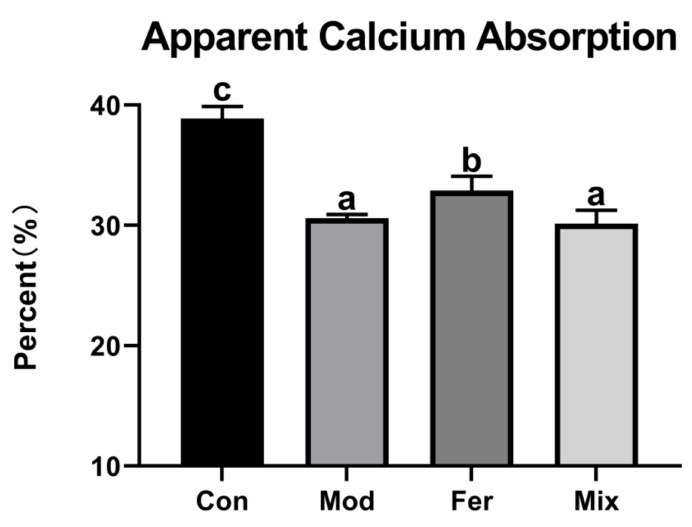
Figure 1. FS more significantly restored apparent calcium absorption in osteoporotic rats. Rats in each group were fed in metabolic cages 3 days before the end of the experiment, and the intake, gavage volumes, and feces were recorded for 3 days. Calcium content was detected by ICP-MS. Apparent calcium absorption (%) = (calcium intake − fecal calcium)/calcium intake × 100%; calcium intake (g) = calcium content in feed (g/kg) × feed consumption (kg) + gavage dose (mL) × gavage calcium content (g/mL); fecal calcium (g/kg) = calcium content in feces (g/kg) × total mass of feces (kg). Values are expressed as mean ± SD (n = 6). With p < 0.05, values with various superscript letters differ